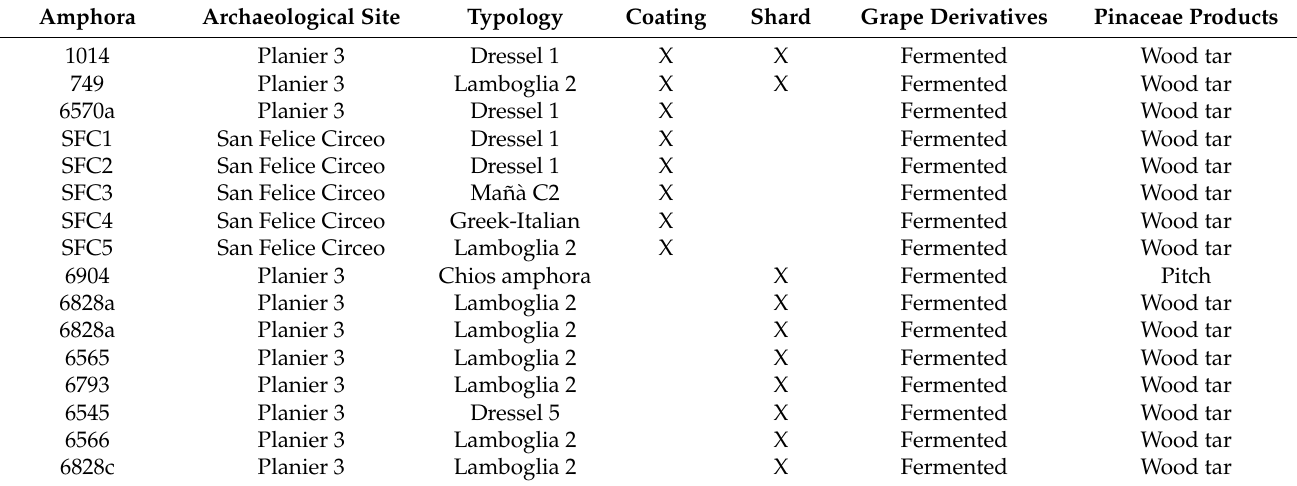
Table 1. Archaeological amphorae